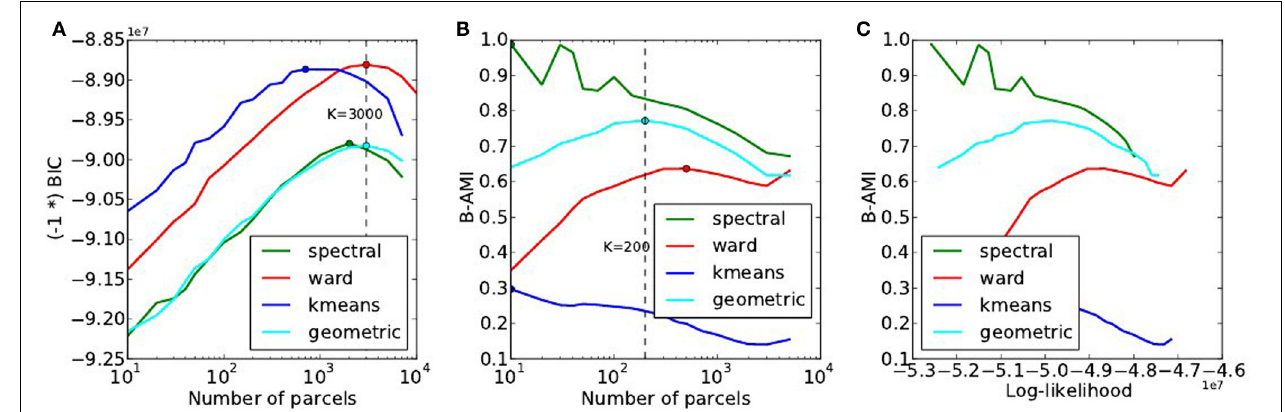
FIGURE 8 | Results of the of the model selection experiments on the HCP dataset. (A) Accuracy-based selection through the BIC score, (B) reproducibility-based selection through Bootstrapped Adjusted Mutual Information, (C) ensuing sensitivity/reproducibility